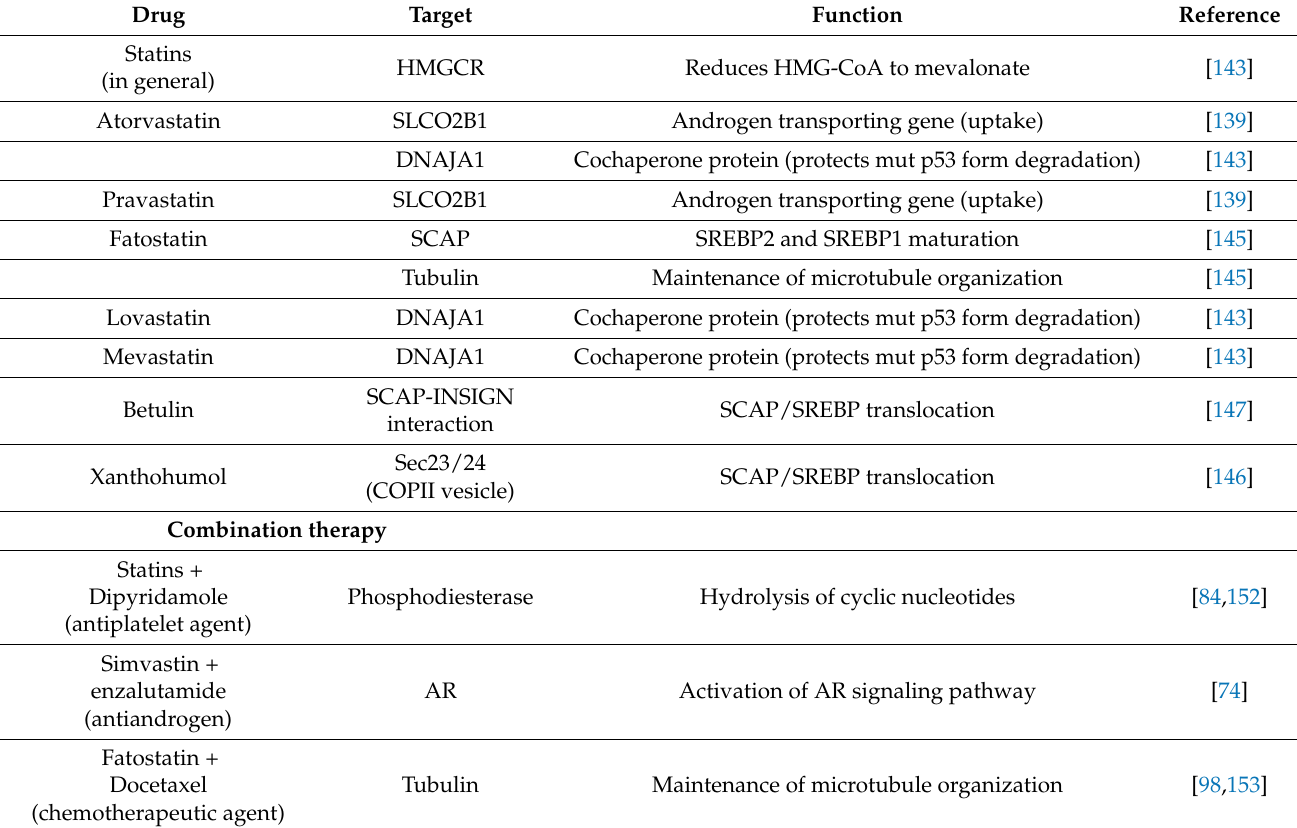
Table 1. List of cholesterol-lowering drugs, their targets and cellular function with emphasize on particular statin type. Drug Target